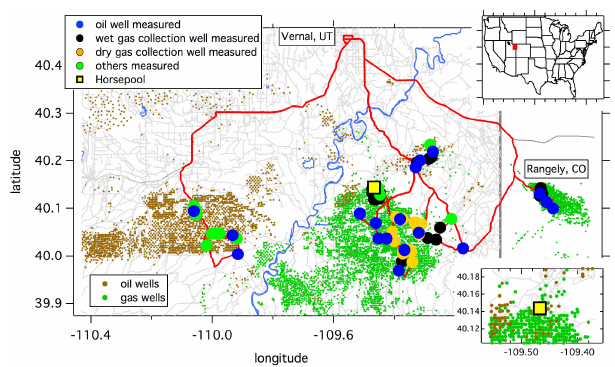
Figure 2. A map of the Uintah Basin study area showing the loca- tions of oil and gas wells and the Horse Pool ground site. The route of the drives (red lines) is shown together with the locations of the investigated point sources. The insert on the top shows the location of the Uintah Basin in the United States and the bottom insert shows the immediate vicinity of the Horse Pool site, which is surrounded by oil and gas wells.